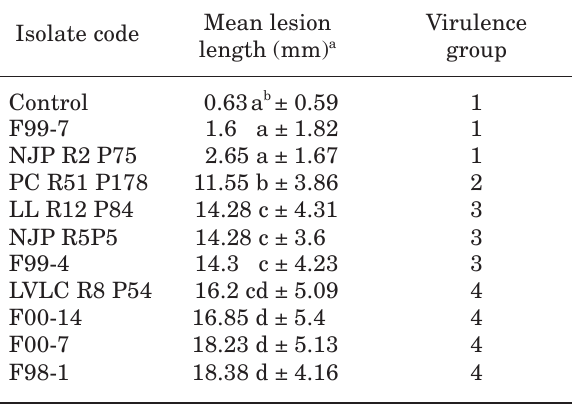
Table 3. Pathogenicity of Botryosphaeria obtusa on 1- year-old canes of Cabernet